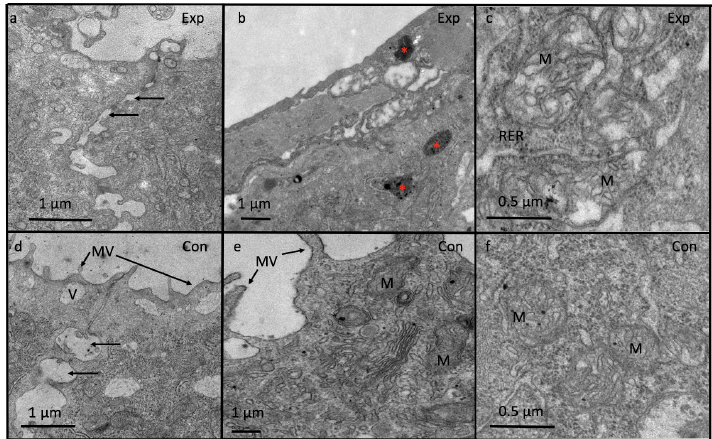
Figure 9. Ultrastructure of wound epithelium at 24 h post amputation showing loss of microvilli (MV), decreased intercellular spaces ( ←− ) (Figure 9a) and increased number of lipid inclusions (*) (Figure 9b) compared to control where microvilli (MV) and intercellular spaces ( ←− ) are prominent (Figure 9c,d). In experimental tadpoles, mitochondria are swollen and fused with wide cristae (Figure 9e) compared to control (Figure 9f). Exp-experimental; Con-control.